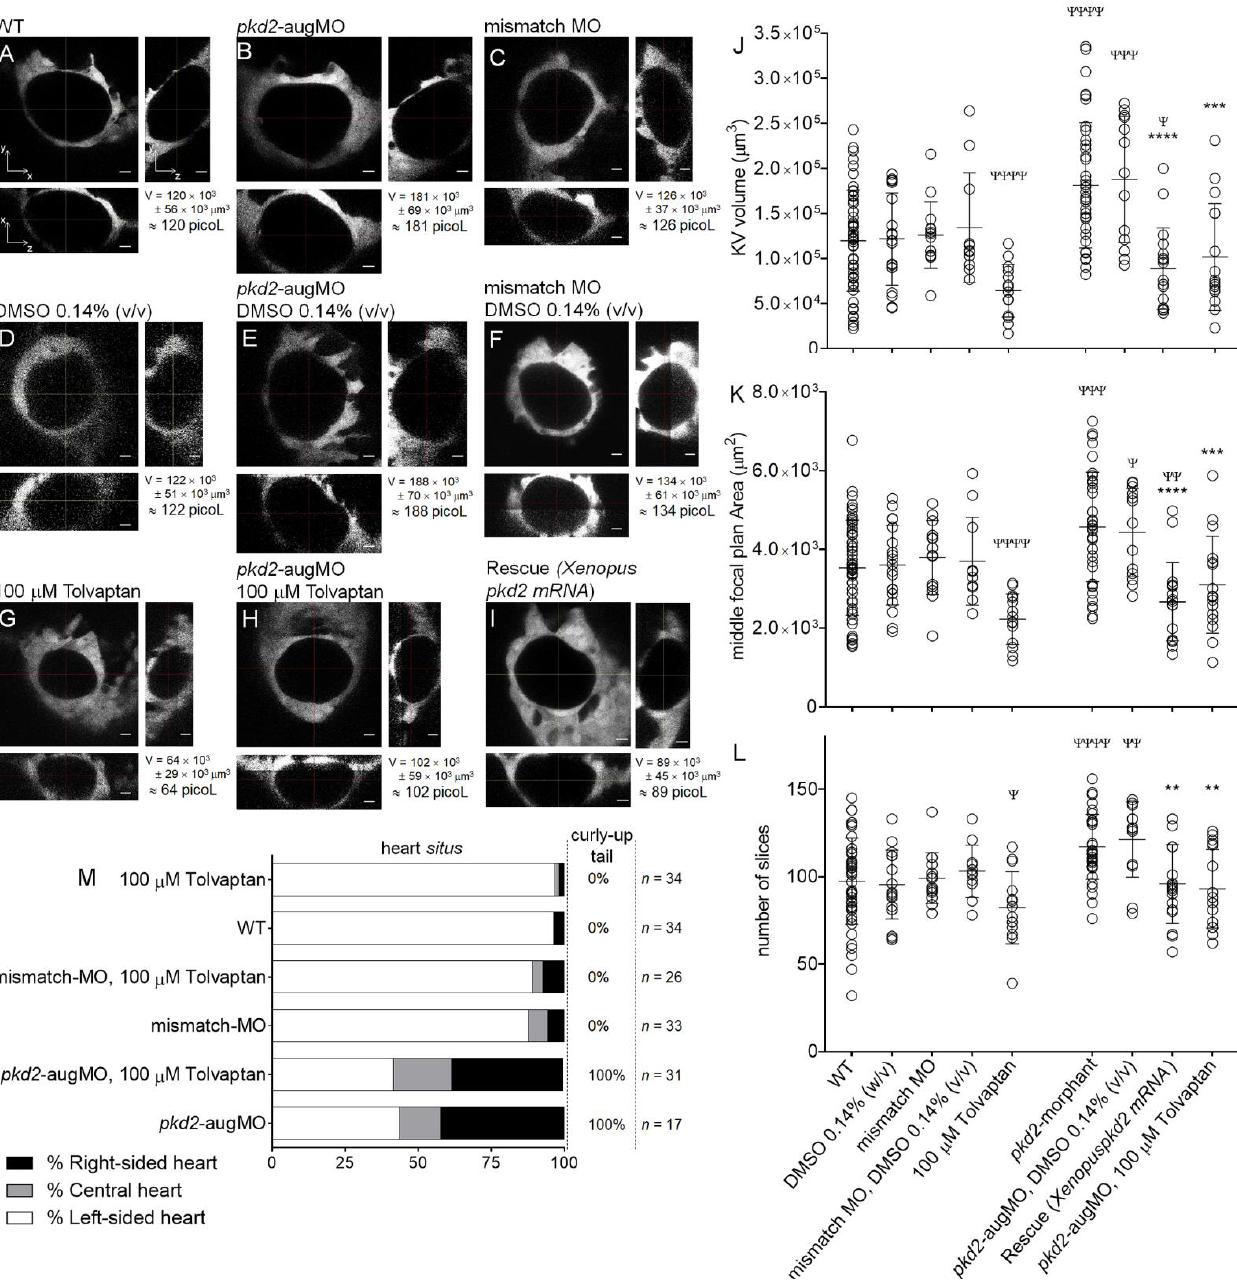
Figure 5. KV volume, a live readout of the CFTR activity. ( A – I ) Confocal live-microscopy scans of whole KVs from sox17 :GFP transgenic embryos, at 10–11 ss. The middle focal plane along the xy axis and its respective orthogonal views (along xz and yz axes) are shown for the most representative embryos: WT ( A ), pkd2 -knockdown ( B ), mismatch MO ( C ), WT + 0.14% ( v / v ) DMSO ( D ), pkd2 -knockdown + 0.14% ( v / v ) DMSO ( E ), mismatch MO + 0.14% ( v / v ) DMSO ( F ), WT + 100 μM tolvaptan ( G ), pkd2 -knockdown + 100 μM tolvaptan ( H ), and rescue ( pkd2 -knockdown + Xenopus pkd2-mRNA ) ( I ). KV volume is indicated in μm 3 and in picoliters. Scale bars: 10 μm. ( J , K , L ) Estimated KV volumes (μm 3 ), middle focal plan area (μm 2 ) and number of slices of the z-stacks for WT ( n = 51), WT treated with 0.14% ( v / v ) DMSO ( n = 19), mismatch-MO ( n = 14), mismatch MO + 0.14% ( v / v ) DMSO ( n = 11), 100 μM tolvaptan ( n = 14), pkd2 -knockdown ( n = 38), pkd2 -knockdown treated with 0.14% ( v / v ) DMSO ( n = 13), 100 μM tolvaptan ( n = 16), and rescue ( pkd2 -knockdown + Xenopus pkd2-mRNA ) ( n = 18). Mean ± S.D. All samples, except mismatch MO + 0.14% ( v / v ) DMSO volume and middle focal plan area, pkd2 -knockdown + 100 μM tolvaptan volume, pkd2 -knockdown number of slices, and pkd2 -knockdown + 0.14% ( v / v ) DMSO number of slices, had a normal distribution. The comparisons of samples that did not have normal distribution with respective WT and pkd2 -knockdown samples were analyzed with the Mann–Whitney test. t -test with the Welch correction